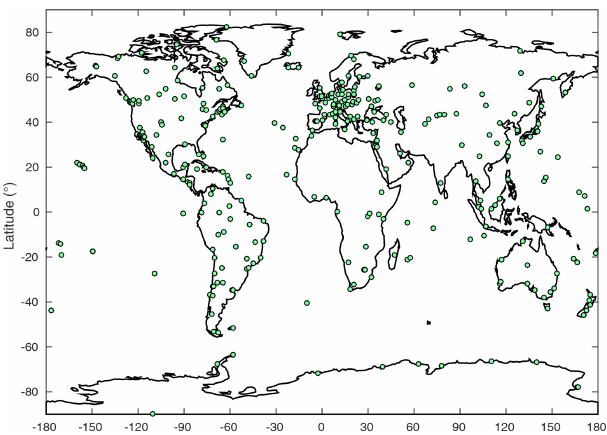
Figure 1. Distribution of the GPS receiver stations used to derive the ungridded TEC used in the model evaluation in addition to the IGS